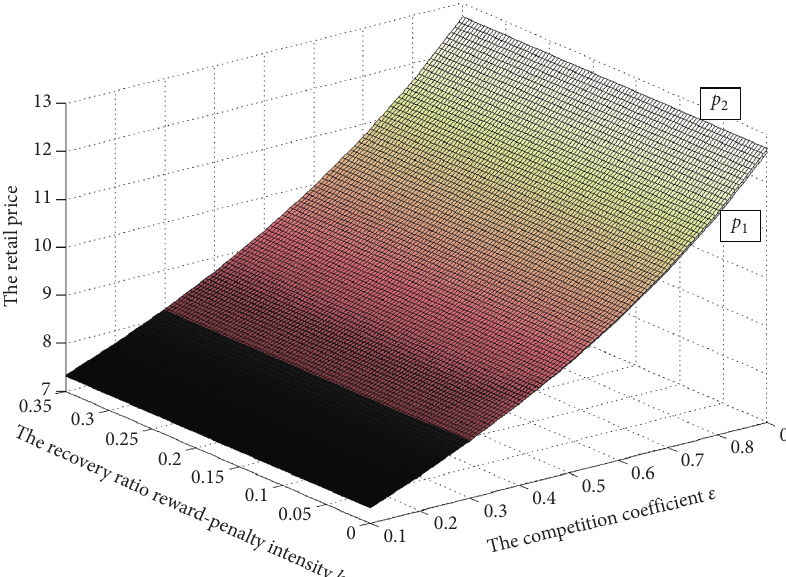
Figure 11: The retail price p